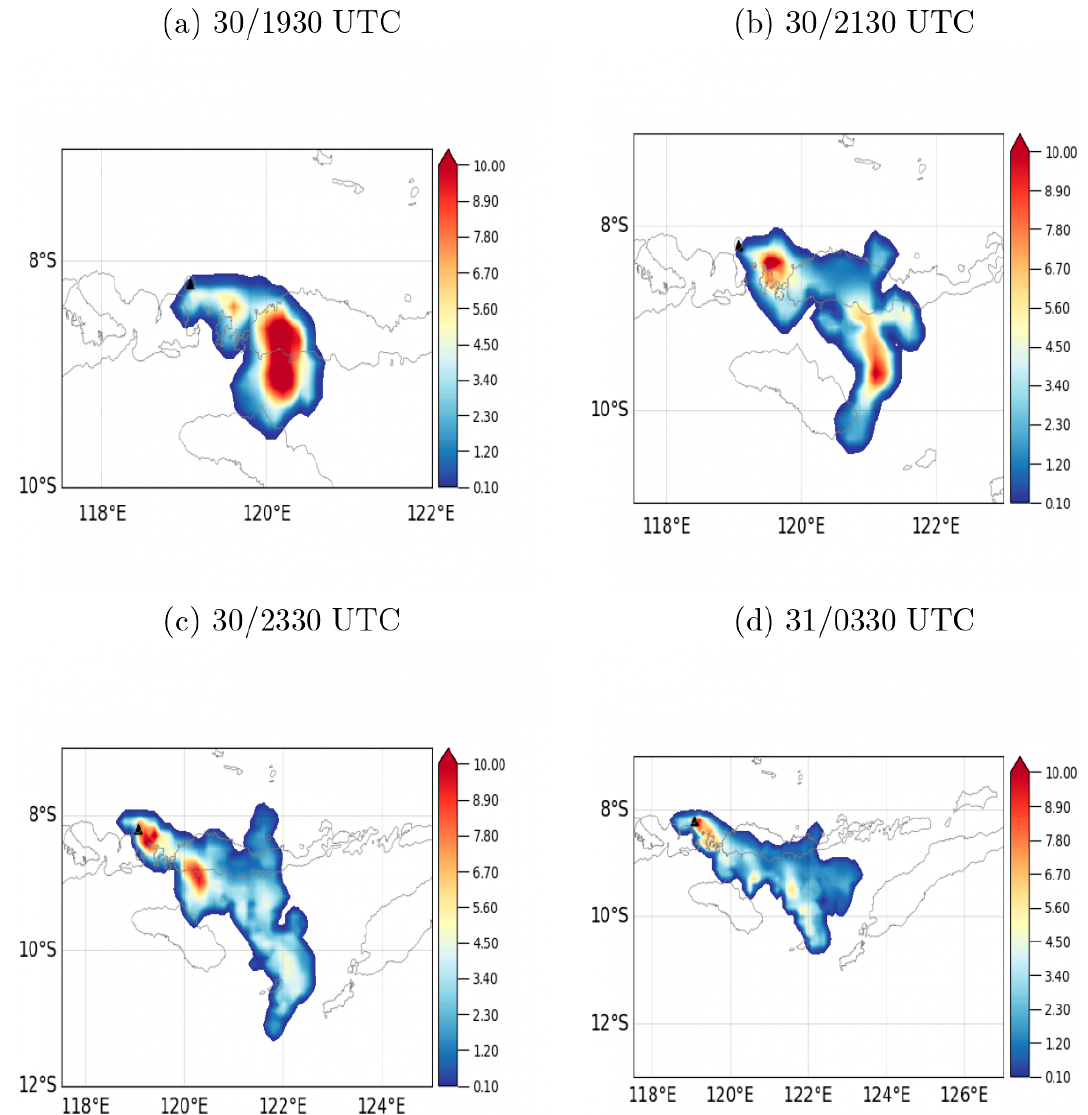
Figure 2. VOLCAT mass load retrievals (in g/m 2 ) corresponding to the 30 May Sangeang Api eruption at times indicated on the panels. The black triangle indicates the volcano location.